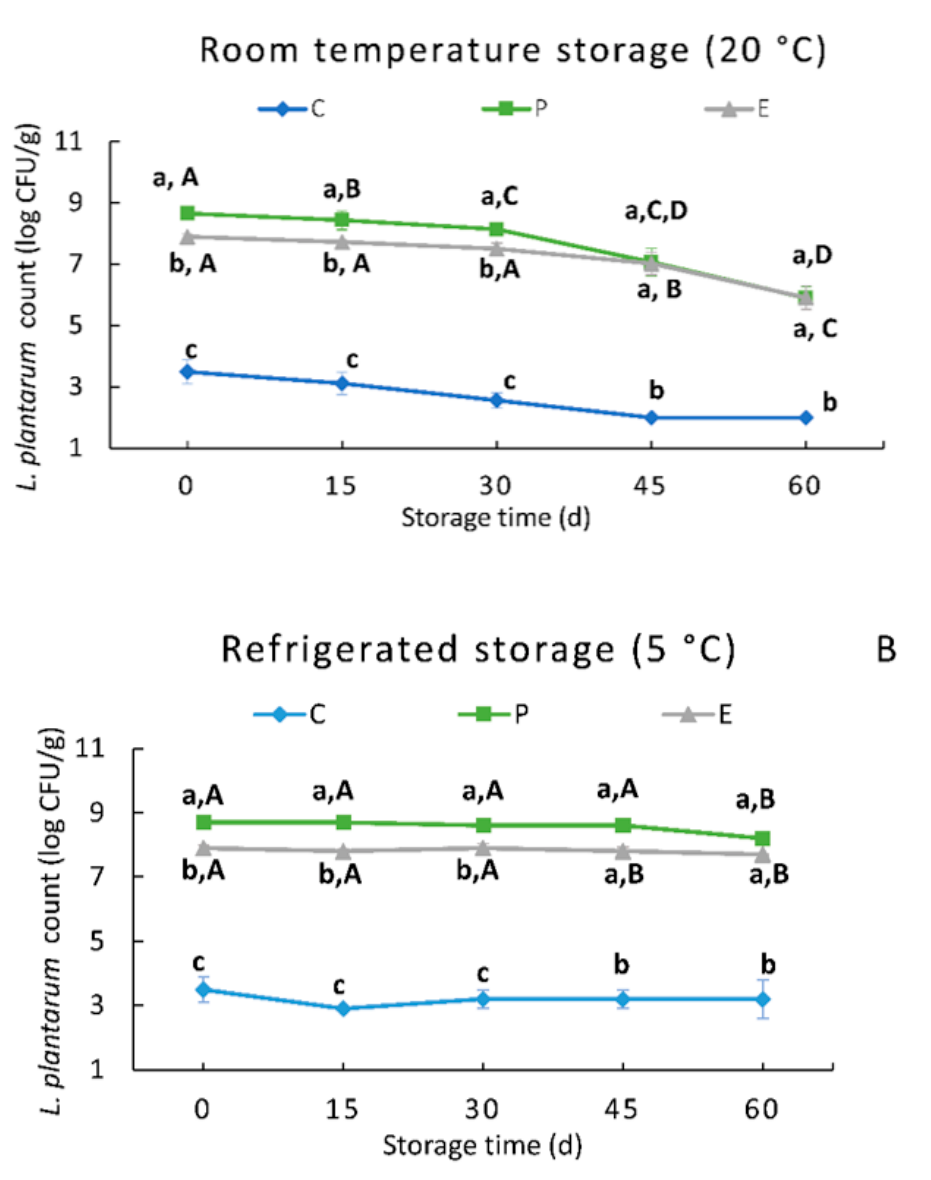
Figure 3. ( A ) : Viability of microencapsulated L. plantarum BFL (E) and free L. plantarum BFL (P) (means ± standard deviations) during 60 d of room temperature storage (20 °C) of Salamines Criollos. ( B ) : Viability of microencapsulated L. plantarum BFL (E) and free L. plantarum BFL (P) (means ± standard deviations) during 60 d of refrigerated storage (5 °C) of Salamines Criollos. Different capital letters express significant differences ( p < 0.05) within the same treatment throughout the 60 days. Different lowercase letters express significant differences between treatments on the same day.